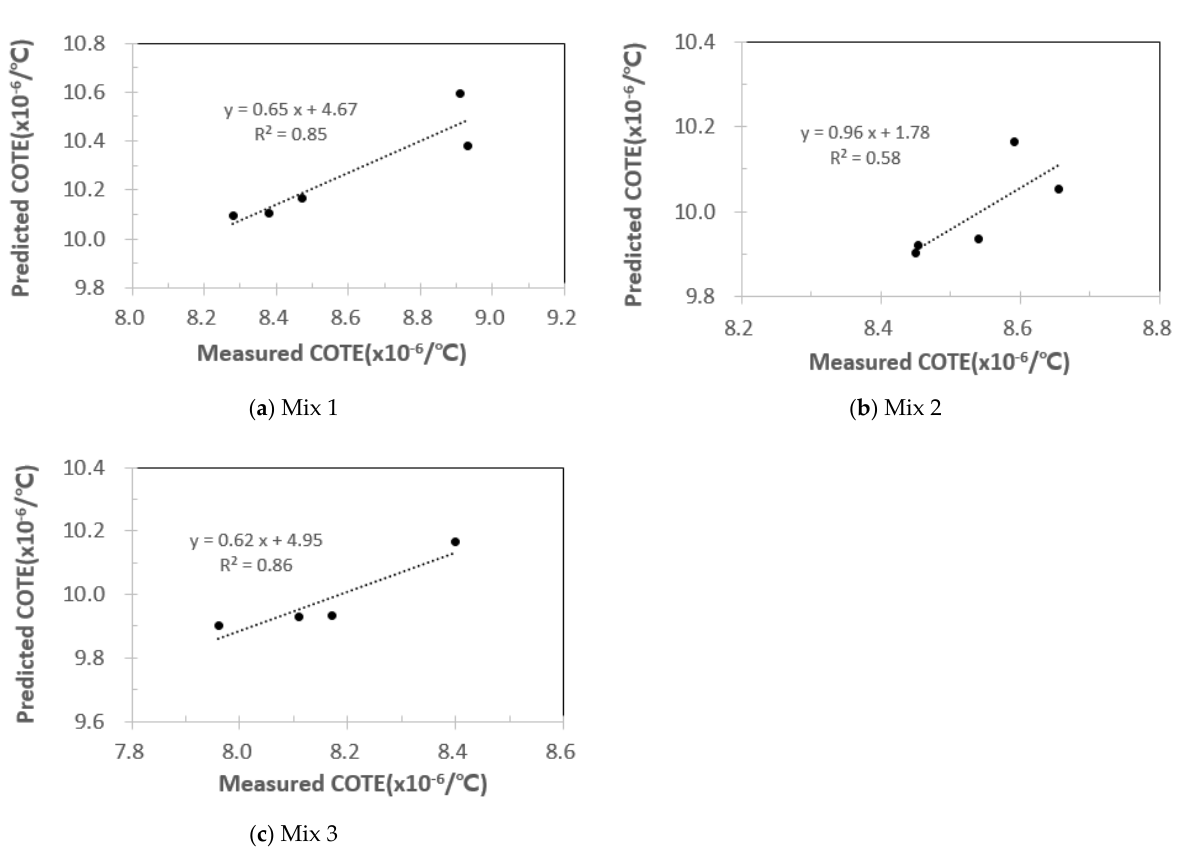
Figure 10. Predicted COTE values versus measured COTE values in various mixes.